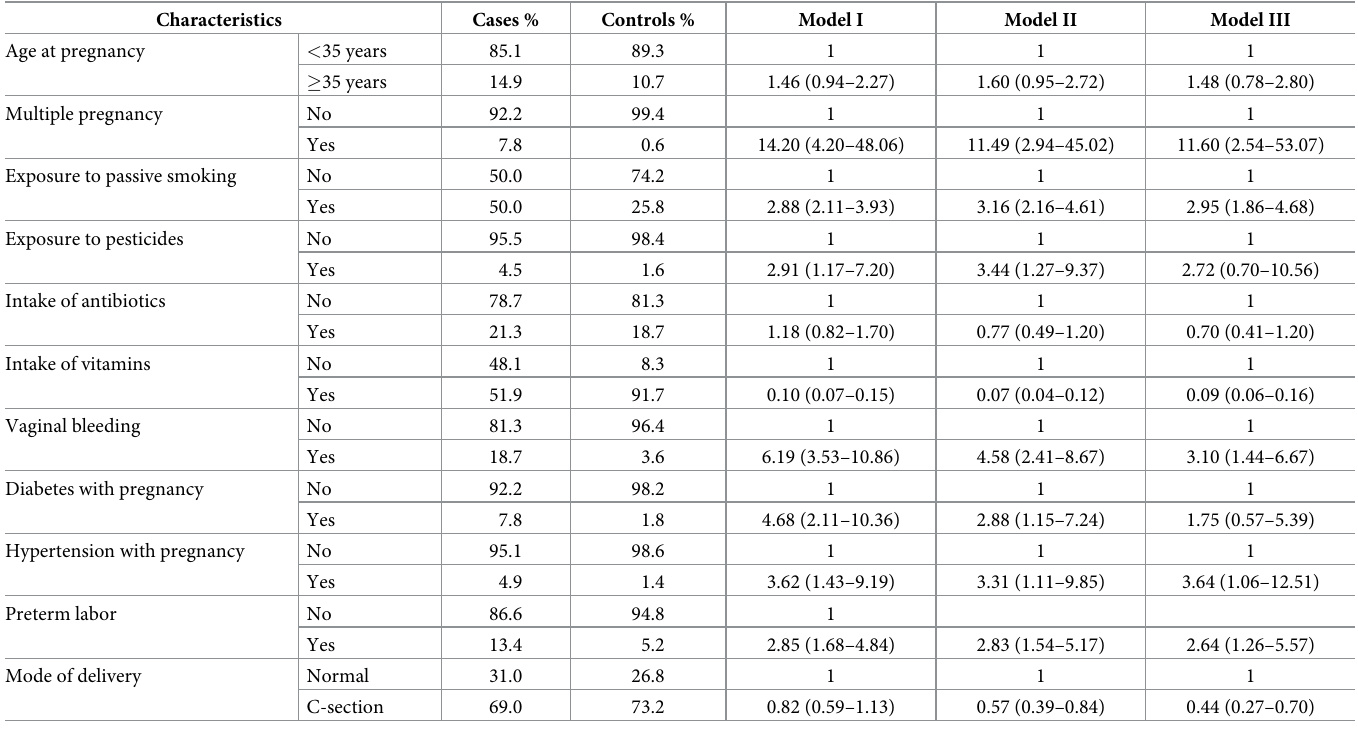
Table 3. Conception maternal predictors of autism spectrum disorder.